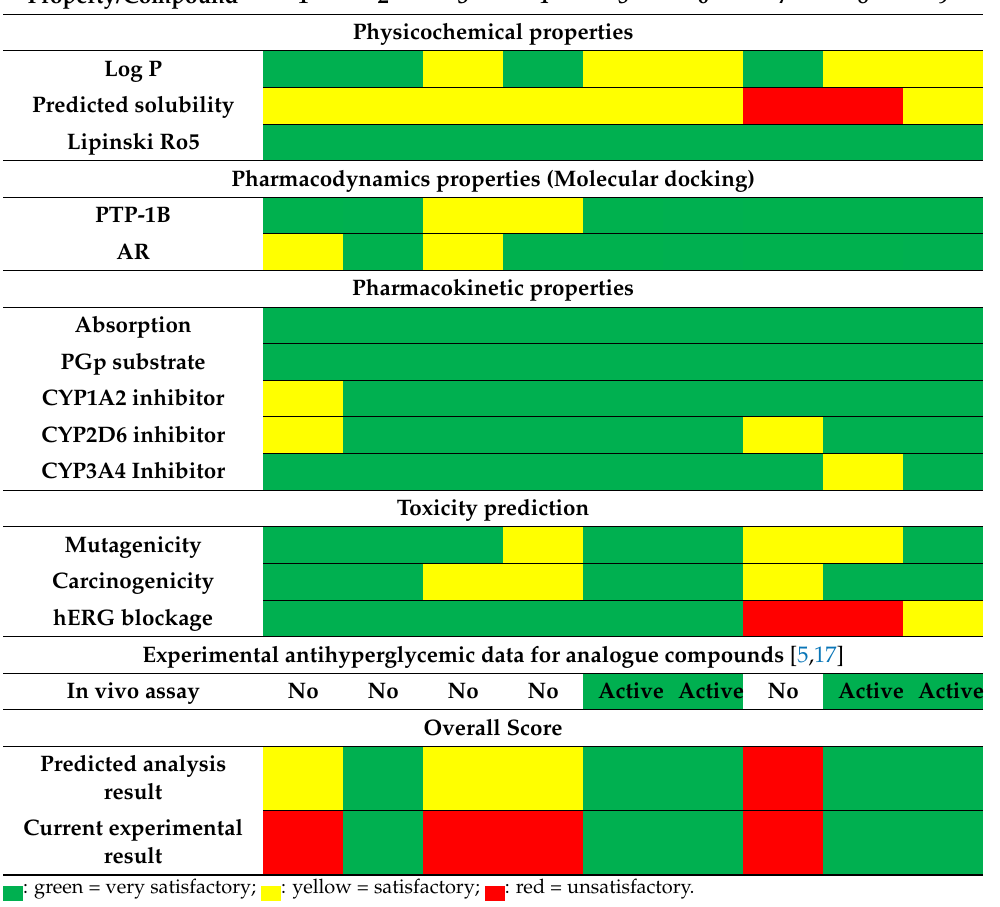
Table 2. Color code pharmacological consensus analysis (PHACA) for the evaluated compounds.